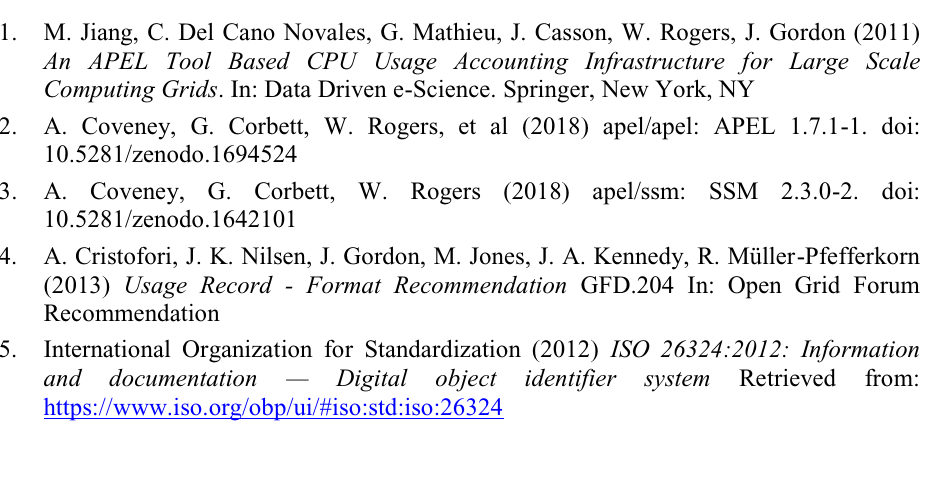
Table 1 Metrics used in the final